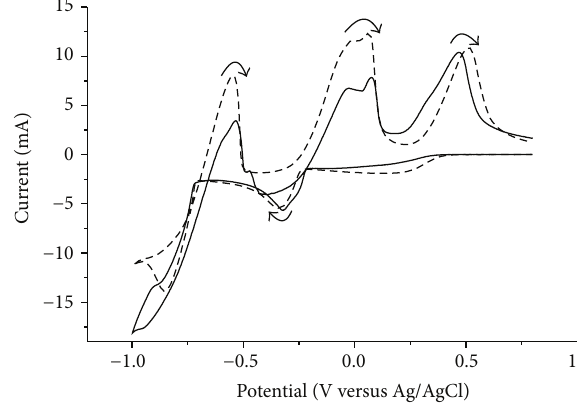
Figure 3: Voltammogram of the two solutions containing dissolved real waste material, Solution 2 (solid line) and Solution 3 (dashed line), at a scan rate of